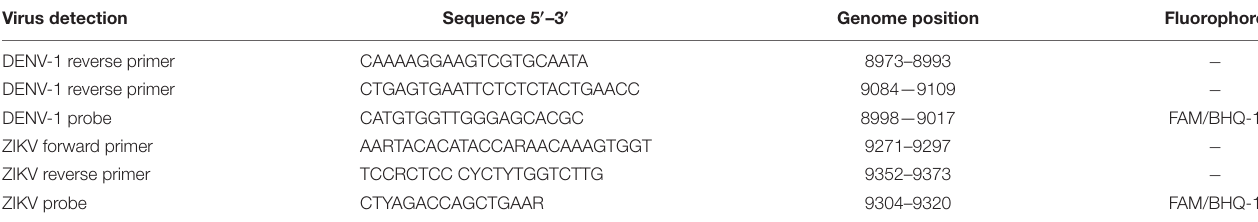
TABLE 1 | Oligonucleotide primers and fluorogenic probes used in DENV-1 and ZIKV virus qPCR assay. Virus detection Sequence 5 (cid:48) –3 (cid:48) Genome position